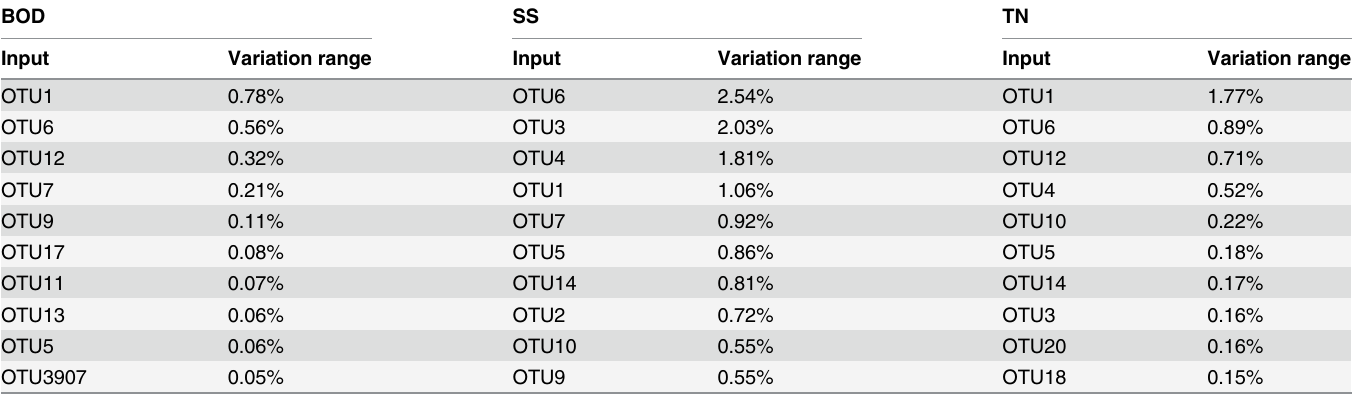
Table 3. Sensitivity rank of top 10 input variables in support vector regression (SVR). BOD